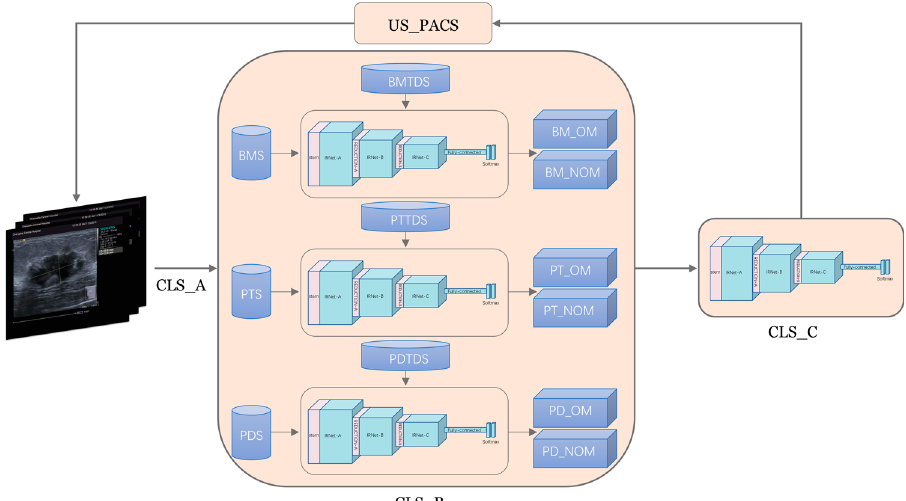
Fig. 2 CLS training and diagnosis fl owchart. CLS continuous learning system, US_PACS ultrasound picture archiving and communication system, BMS benign and malignant set, PTS pathological type set, PDS pathological disease set, BMTDS benign and malignant diagnostic test dataset, PTTDS pathological type diagnostic test dataset, PDTDS pathological disease diagnosis test dataset, BM_OM benign and malignant diagnostic optimization model, BM_NOM benign and malignant diagnostic non-optimal model, PT_OM pathological type diagnostic optimization model, PT_NOM pathological type diagnostic non-optimal model, PD_OM pathological disease diagnosis optimization model, PD_NOM pathological disease diagnosis non-optimal